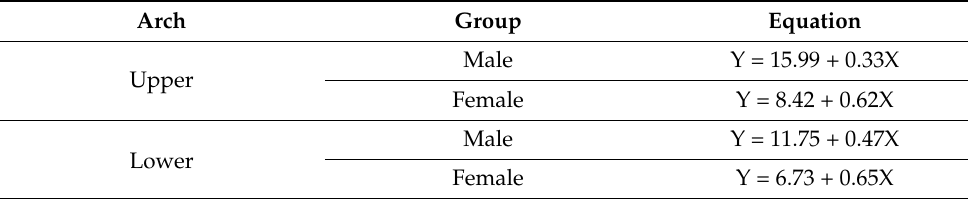
Table 5. Regression